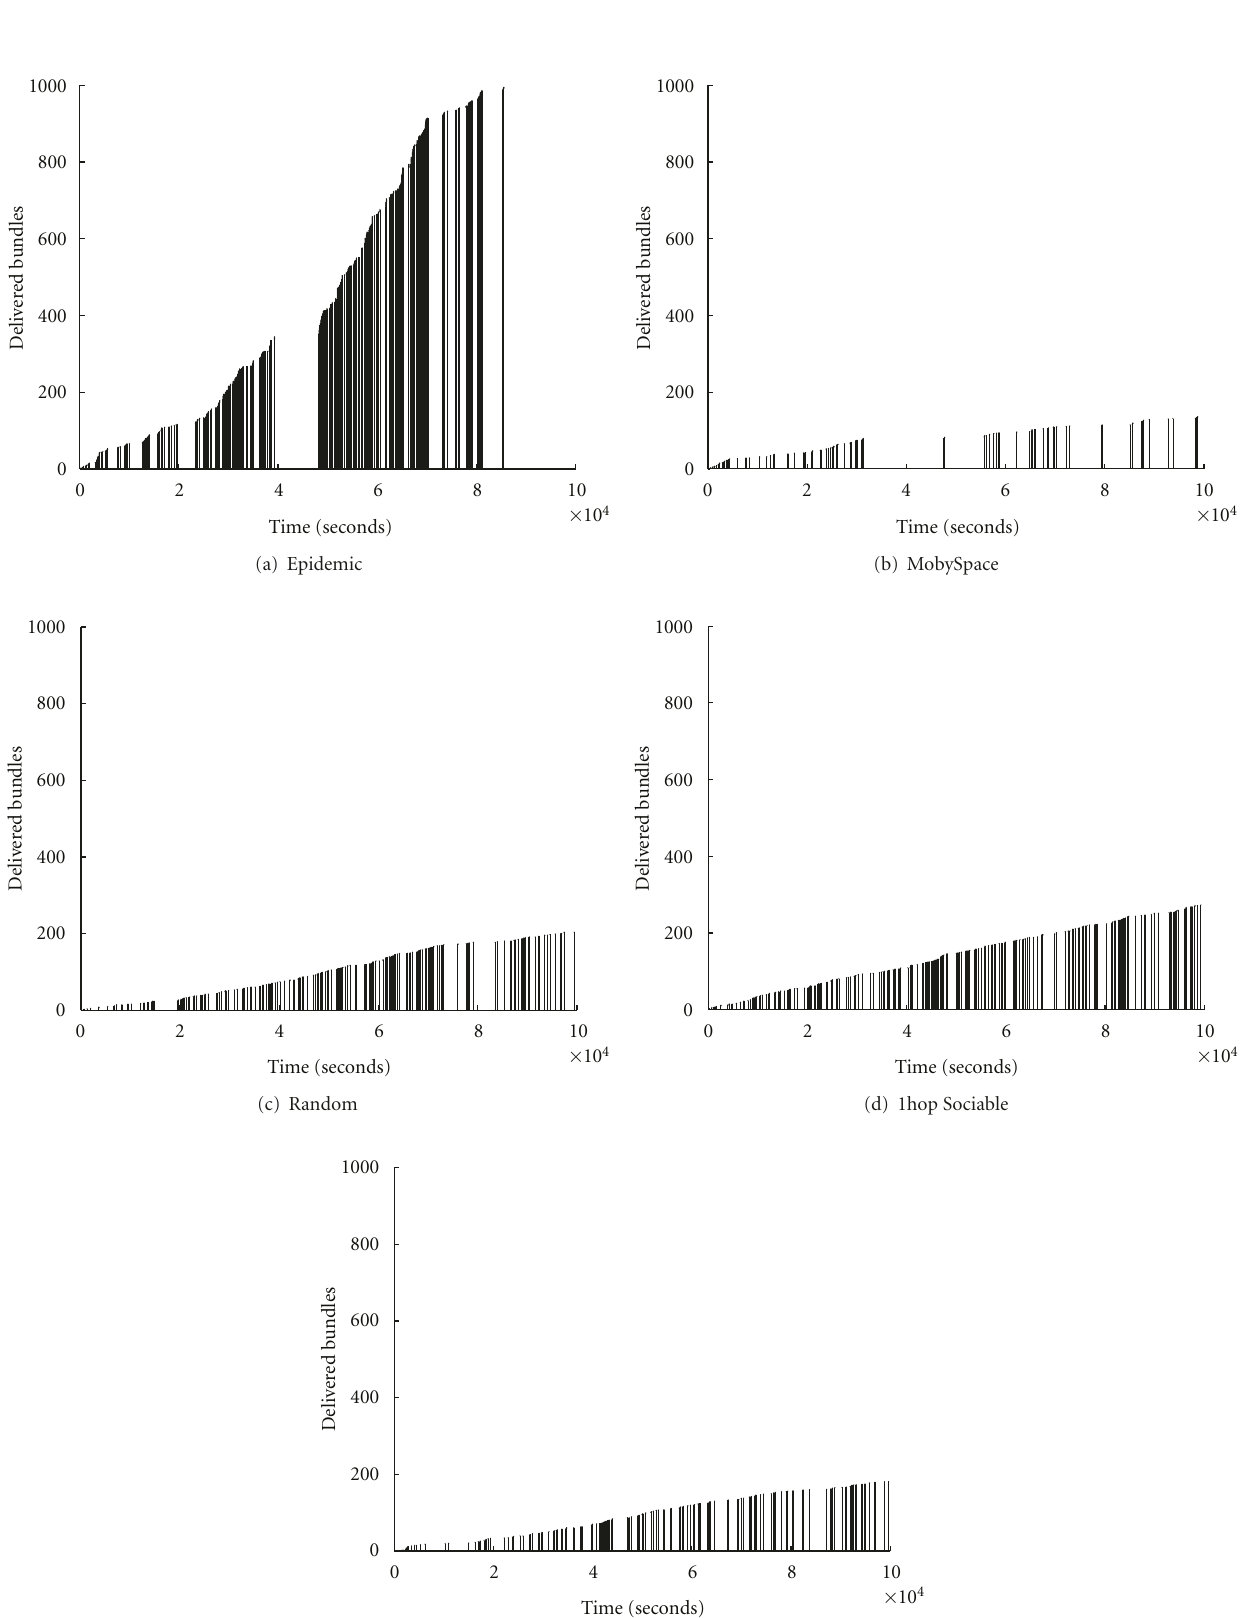
Figure 5: Cumulative bundles delivery over time for the routing scheme